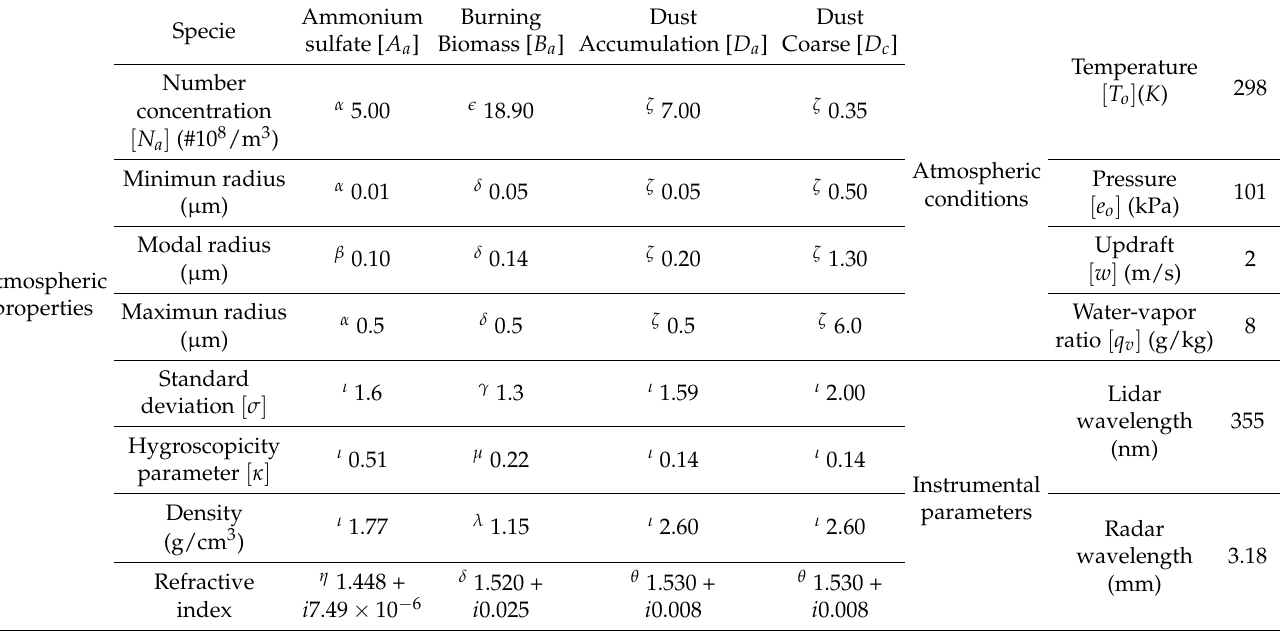
Table 6. Initial parameters used for the different aerosol types. Source: α Mészáros [32], β Tu and Kanapilly [35], γ D’Almeida et al. [50], δ Remer et al. [47], (cid:101) Keil and Haywood [48], ζ Dentener et al. [46], η Curtis et al. [34], θ Denjean et al. [49], ι Hande et al. [33], λ Zhai et al. [45], and µ Psichoudaki et al.